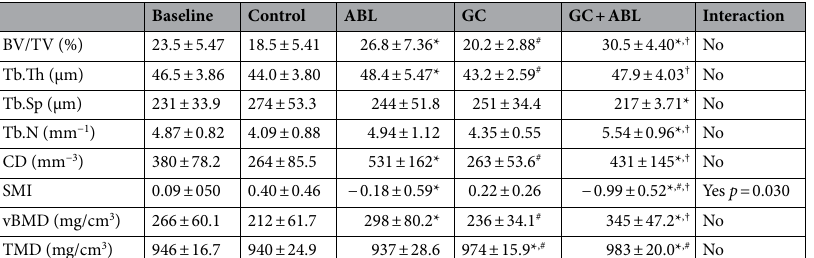
Table 4. Microstructural properties of L4 of mice subjected to subcutaneous slow-release glucocorticoid (GC) pellets and treated with abaloparatide (ABL) for four weeks. BV/TV bone volume/tissue volume, Tb. Th trabecular thickness, Tb.Sp trabecular spacing, Tb.N trabecular number, CD connectivity density, SMI structure model index, vBMD volumetric bone mineral density, and TMD tissue mineral density. Mean ± SD. * p < 0.05 vs. Control. # p < 0.05 vs. ABL. † p < 0.05 vs. GC.